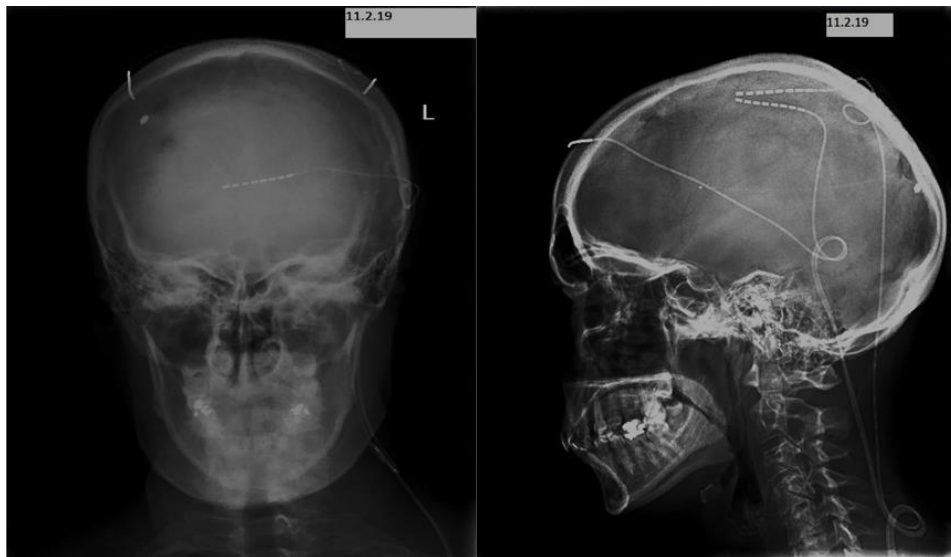
Figure 2. Coronal and sagittal imaging of the placement of three leads with 8 contacts (two leads at the area of parietal lobes symmetrically on both sides and one lead occipital under the superior nuchal line).